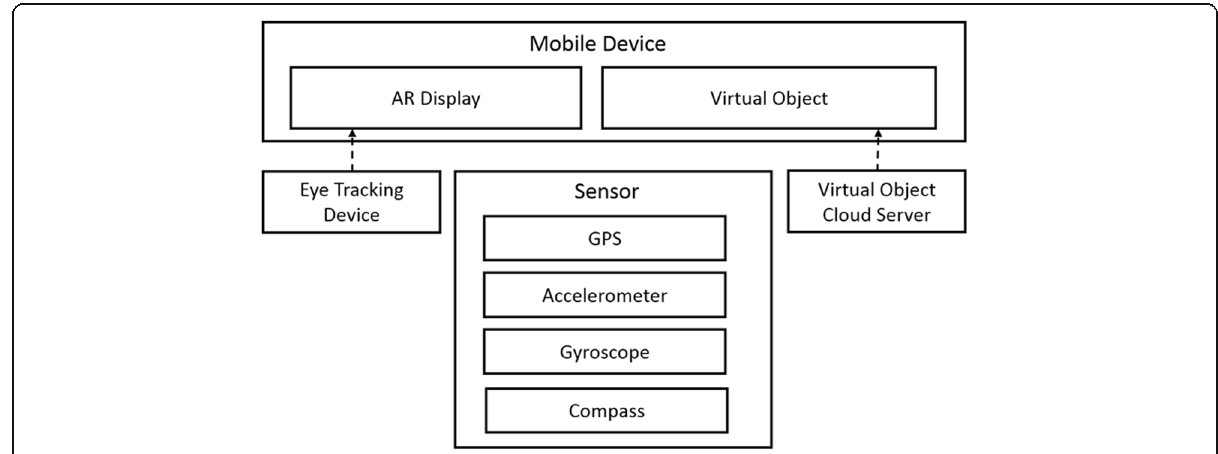
Fig. 3 Mobile AR game components. A conceptual diagram of mobile AR game